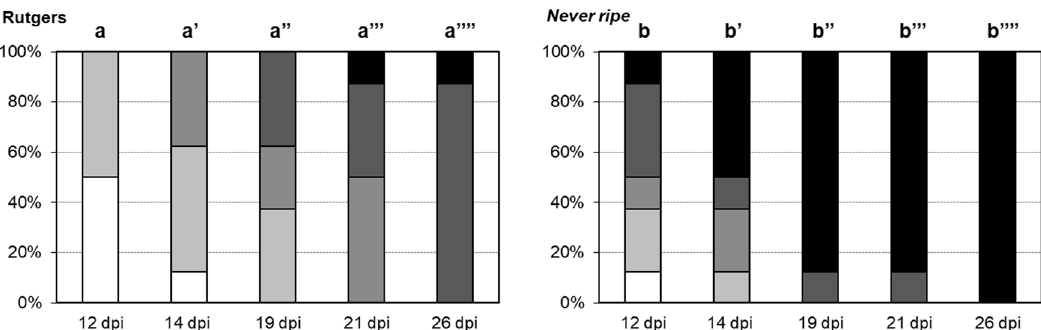
Figure 3. Disease severity of CEVd infected Rutgers and Never ripe tomato plants. Symptomatology was scored at 12, 14, 19, 21 and 26 days post inoculation (dpi), using the following scale: no symptoms (white), mild epinasty (light grey), severe epinasty and stunting (grey), leaf rugosity (dark grey), midvein necrosis and chlorosis (black). Data correspond to one representative experiment. Data were analyzed using a Mann–Whitney test and different letters indicate significant differences ( p < 0.05). Number of ( ’ ) indicates different days.